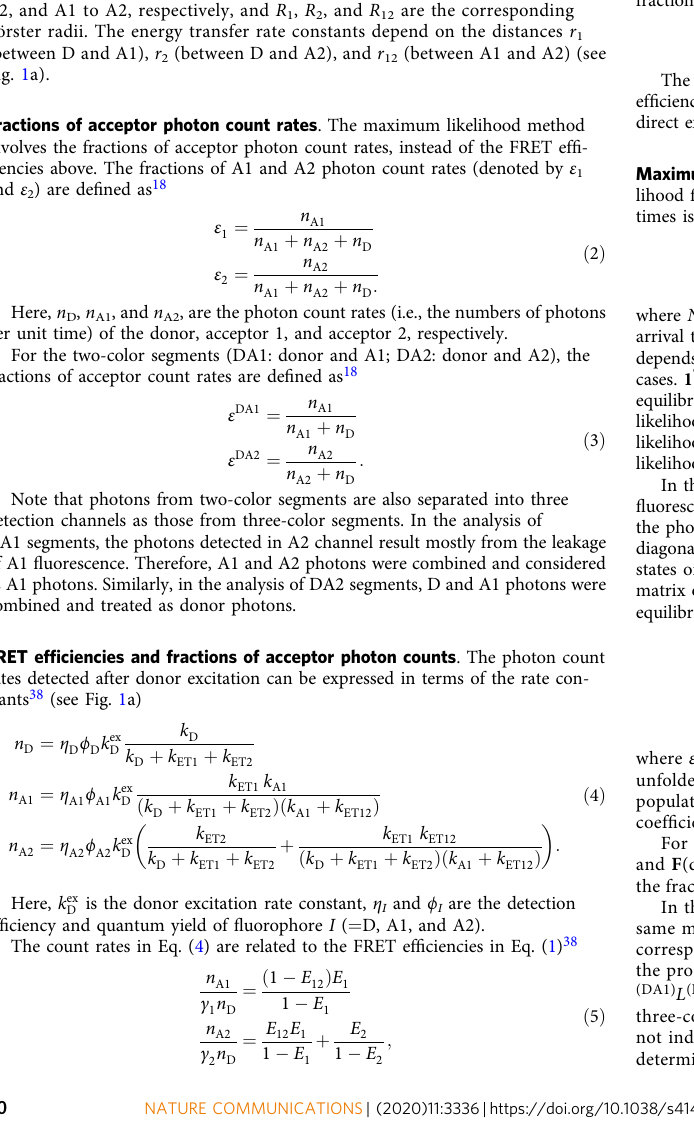
In two-color FRET, the FRET ef fi ciencies are found from the two-color acceptor fractions (see Eqs. (3) and (5) with E 12 set to 0)